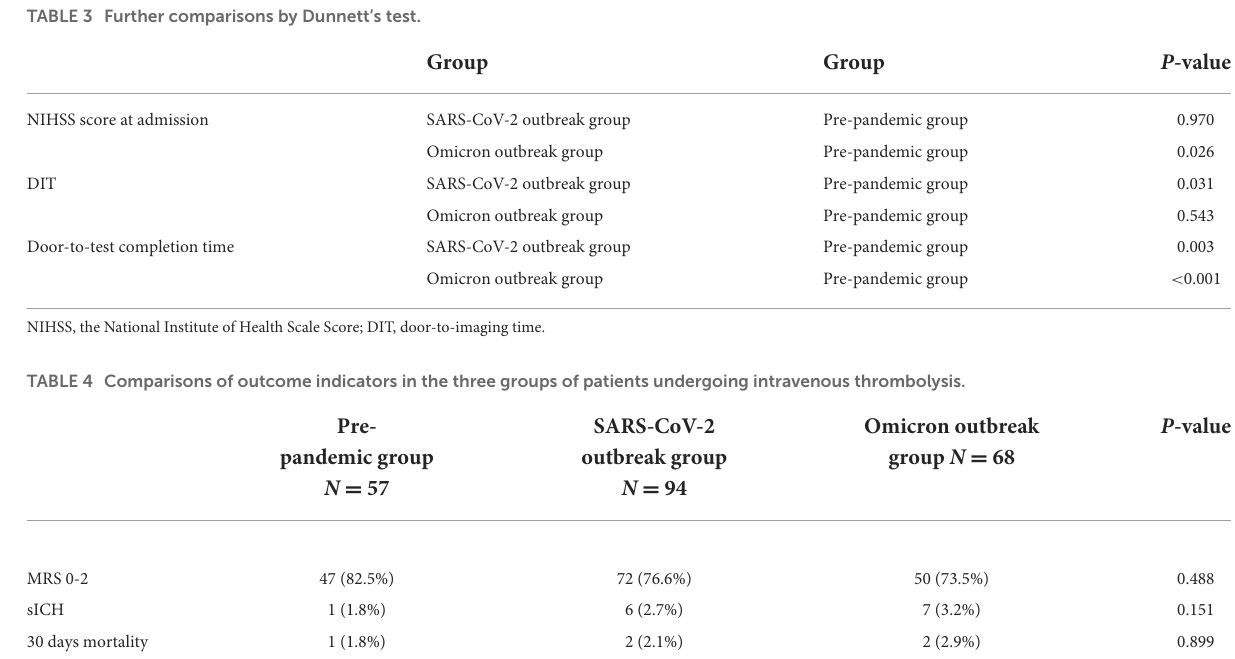
TABLE 3 Further comparisons by Dunnett’s test.